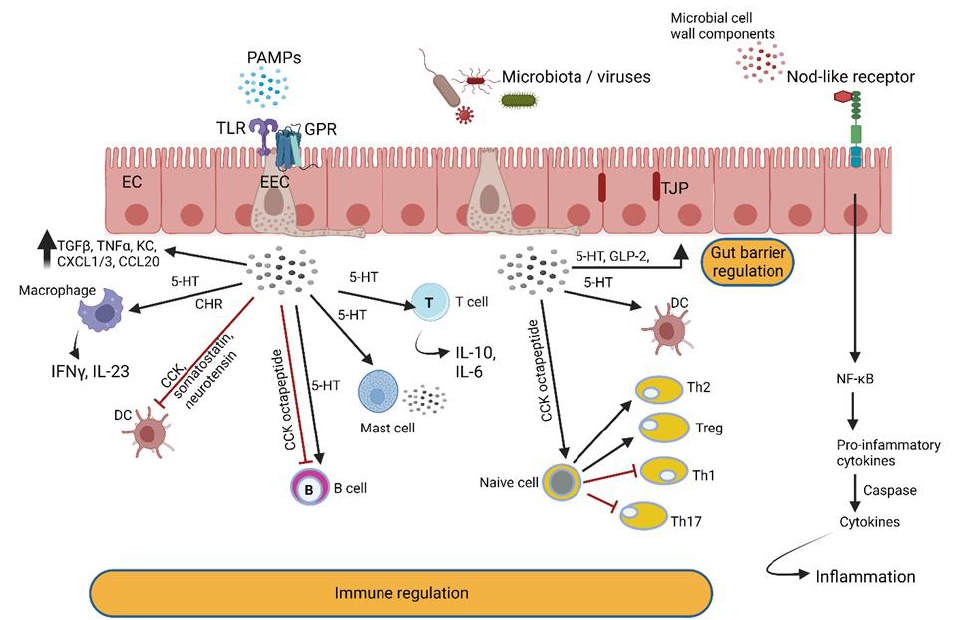
Figure 6. Enteroendocrine cells (EECs) in the gut wall detect intestinal bacteria and microbial metabo- Figure 6 . Enteroendocrine cells (EECs) in the gut wall detect intestinal bacteria and microbial me- 373 lites and react by secreting peptide hormones and cytokines that react with immune cells. Hormones tabolites and react by secreting peptide hormones and cytokines that react with immune cells. Hor- 374 produced by EECs modulate intestinal barrier functions and react with enteric nerves. The latter mones produced by EECs modulate intestinal barrier functions and react with enteric nerves. The 375 communicate with the central nervous system via the vagus nerve. PAMPs = pathogen-associated latter communicate with the central nervous system via the vagus nerve. PAMPs = pathogen-asso- 376 molecular patterns; TLR = Toll-like receptor; GPR = G protein-coupled receptor; TGF = tumor ciated molecular patterns; TLR = Toll-like receptor; GPR = G protein-coupled receptor; TGF = tumor 377 growth factor; TNF = tumor necrosis factor; KC = neutrophil chemokine; CXLC = chemokine (C-X-C growth factor; TNF = tumor necrosis factor; KC = neutrophil chemokine; CXLC = chemokine (C-X- 378 motif) ligand; CCL = chemokine ligand; IFN = interferon; IL = interleukin; CCK = cholecystokinin; C motif) ligand; CCL = chemokine ligand; IFN = interferon; IL = interleukin; CCK = cholecystokinin; 379 DC = dendritic cell; 5-HT = serotonin; Th = T helper cell; Treg = regulatory T cell. This illustration 380 DC = dendritic cell; 5-HT = serotonin; Th = T helper cell; Treg = regulatory T cell. This illustration was constructed using BioRender (https://biorender.com/, assessed on 6 September 2022). 381 was constructed using BioRender (https://biorender.com/, assessed on 6 September 2022). 382 AhRs regulate immune responses and pathogenesis (Figure 7) [122]. Large quantities 383 of AhR are expressed by intestinal epithelial cells and immune cells such as innate lym- 384 phoid cells, intraepithelial lymphocytes, TH17 cells and Treg cells but are also present in 385 the liver, lung, bladder and placenta [123 – 125]. One of the key functions of AhR is resto- 386 ration of barrier homeostasis, a phenomenon eminent in IBD [7]. 387 AhR is activated by metabolic compounds produced from the bacterial degradation 388 of tryptophan [126] but also by 2,4-dihydroxyquinoline (2,4-DHQ) and quinolone deriva- 389 tives [127], pyocyanin, 1-hydroxyphenazine, phenazine-1-carboxylic acid and phenazine- 390 1-carboxamide [128]. Tryptophan degradation products such as indole, indolo [3,2-b]car- 391 bazole, indole acetic acid (IAA), 3-methylindole and tryptamine react with AhR and stim- 392 ulate the production of interleukin-22 [126,129,130]. Individuals with inflammatory bowel 393 disease (IBD) [131], metabolic syndrome [132] or celiac disease [133] have decreased fecal 394 concentrations of AhR ligands and reduced AhR activity. Higher indole concentrations 395 were detected in patients suffering from Clostridioides difficile ( Clostridium difficile ) infection 396 (CDI) compared to healthy individuals [134]. Elevated levels of indole produced by enter- 397 otoxigenic E. coli stimulated the colonization of C. difficile whilst other intestinal bacteria 398 were repressed [134]. When indole was administered to GF mice, the expression of genes 399 encoding tight junction proteins increased and improved the resistance of epithelial cells 400 to colitis [135]. Since Trp is not synthesized by gut microbiota or the host, indole levels are 401 directly linked to diet. Roasted cashew nuts, sunflower seeds, cheddar cheese, chicken 402 breast and boiled eggs are rich in Trp [136]. Figure 7. Summary of aryl hydrocarbon receptor (AhR) pathways. AhR ligands such as 6-formylindolo Figure 7. Summary of aryl hydrocarbon receptor (AhR) pathways. AhR ligands such as 6-formylin- 405 dolo [3,2-b]carbazole; 2,3,7,8-tetrachlorodibenzo-p-dioxin and polycyclic aromatic hydrocarbons 406 cross the cytoplasmic membrane and bind to AhR. The ligand – AhR complex crosses into the nu- 407 cleus and forms a heterodimer with the AhR nuclear translocator (ARNT). Binding of the ligand – 408 AhR – ARNT complex with xenobiotic response elements (XREs) leads to the expression of cyto- 409 chrome P450, family 1, subfamily A, polypeptide 1 (CYP1A1). CYP1A1 degrades AhR ligands. This 410